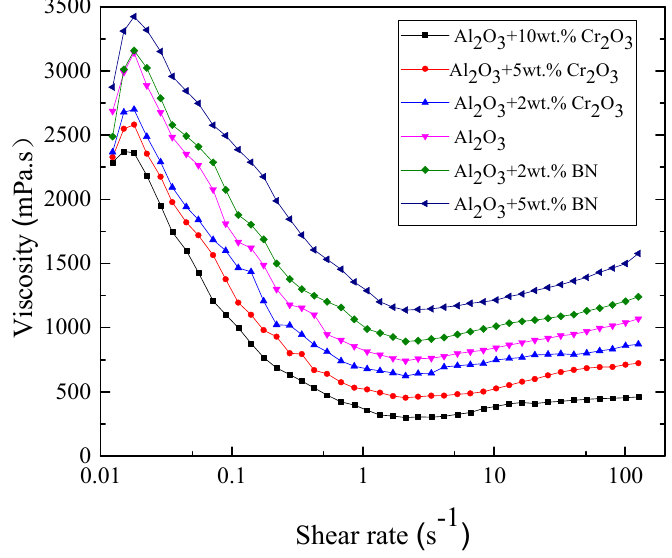
Figure 6. Viscosity as a function of shear rate for various primary slurries (solid loading: 77 wt.%).